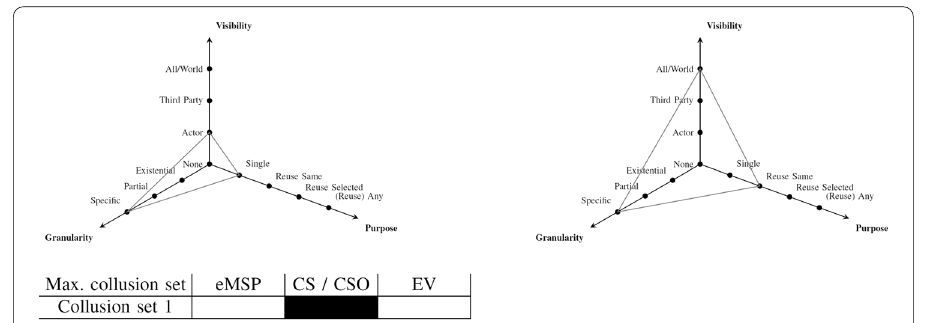
Fig. 8 Privacy dimensions and collusion sets for Gao et al. (2018) for data items (i) personal data (left) and (ii) account (right). Collusion sets 1 refers to the mapping between accounts and the EV’s identity. It is apparent that the collusion set is limited to the CS and the CSO and thus very